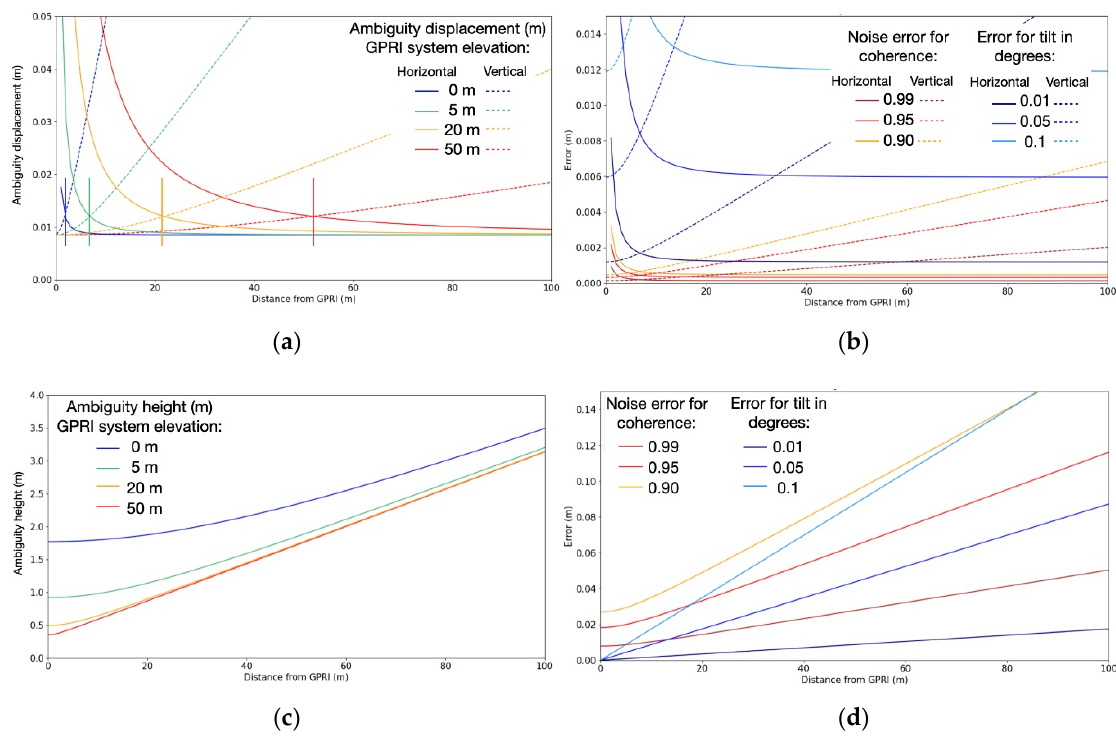
Figure 3. ( a ) Horizontal and vertical ambiguity displacement for a GPRI stationed at different elevations. Vertical lines indicate the range distance of equal sensitivity to vertical and horizontal motion. ( b ) Error in horizontal (solid lines) and vertically (dashed lines) derived motion based on coherence (warm colors) and surface tilt (cool colors) if stationed on a 5-m ridge. ( c ) Ambiguity height for a GPRI stationed at the same levels as in ( a ). ( d ) Error in height estimates with similar coherence and tilt values as in ( b ). Table 1. Ambiguity and error values with range.